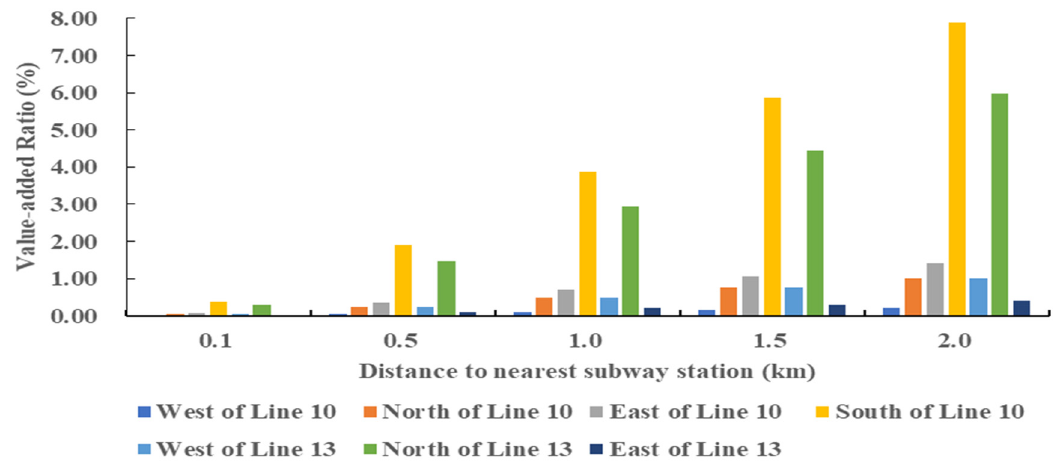
Figure 6. Value-added effect of Metro Line 10 and Line 13 on residential prices.